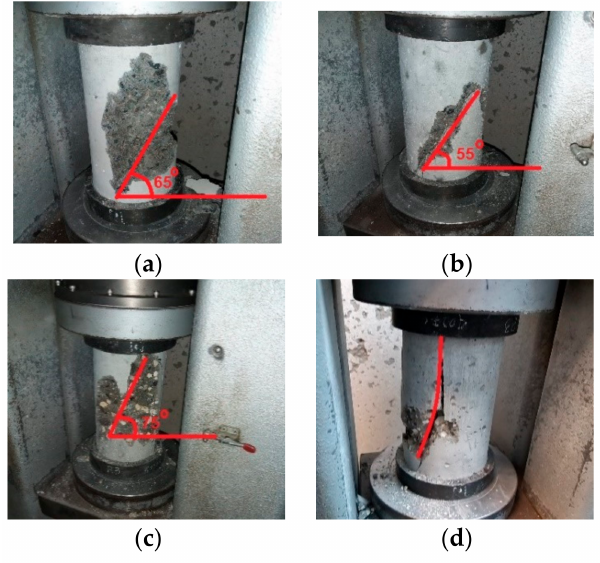
Figure 1. Failure modes of the strongest cylinder specimens under compression at 28 days: ( a ) Mix A; ( b ) Mix B; ( c ) Mix C; and ( d ) Mix